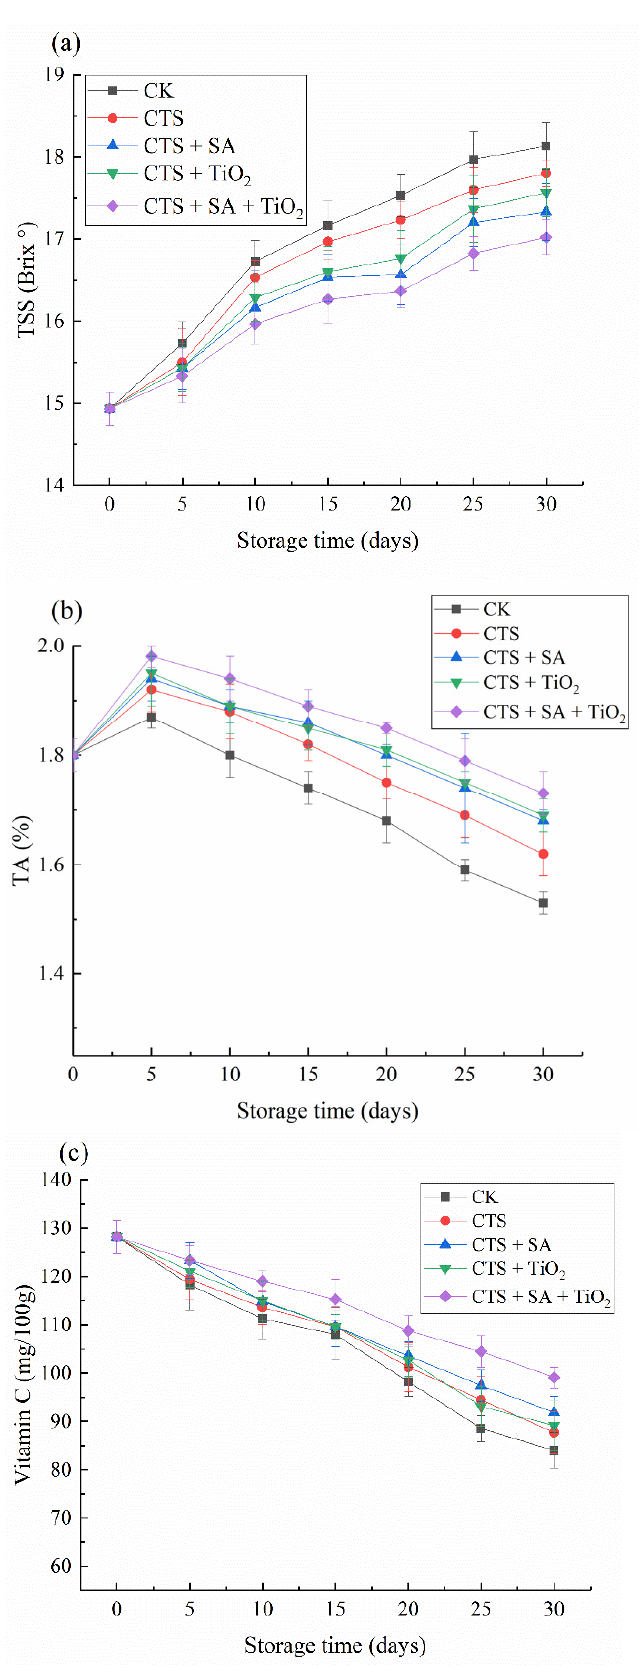
Figure 2. Total soluble solids content: ( a ), titratable acid content ( b ), VC content ( c ) of the samples during 30-day storage at 4 °C.